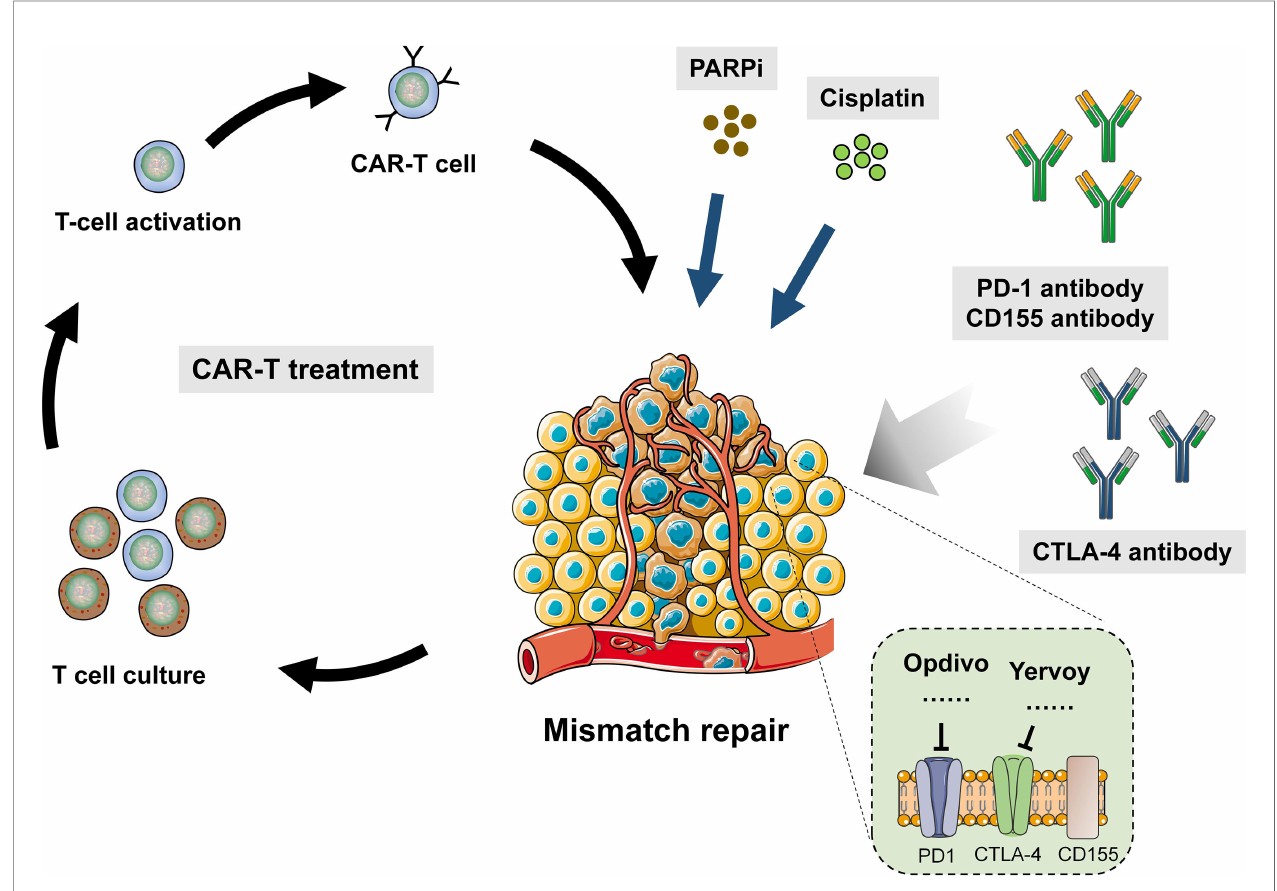
FIGURE 2 | Combination of DDR drug and immunotherapy in human